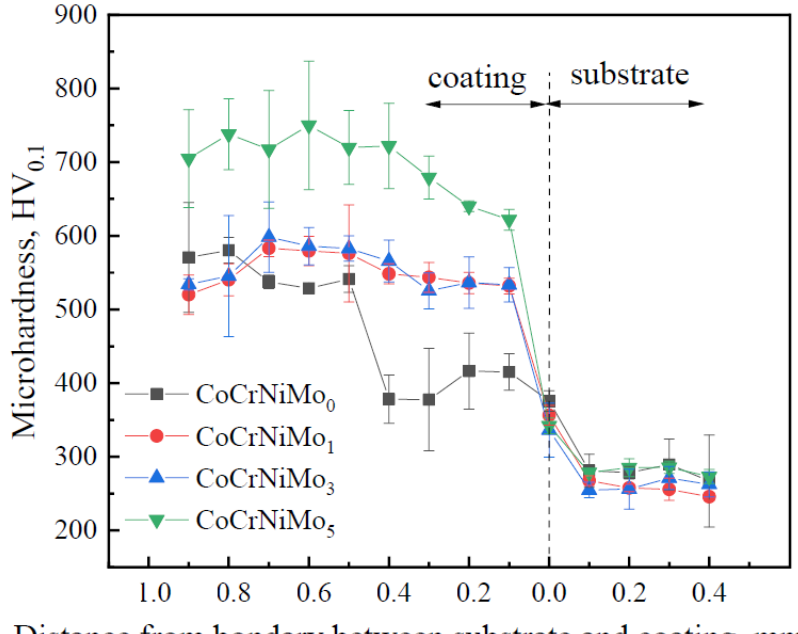
Figure 9. Microhardness curves from the boundary between substrate and coating.